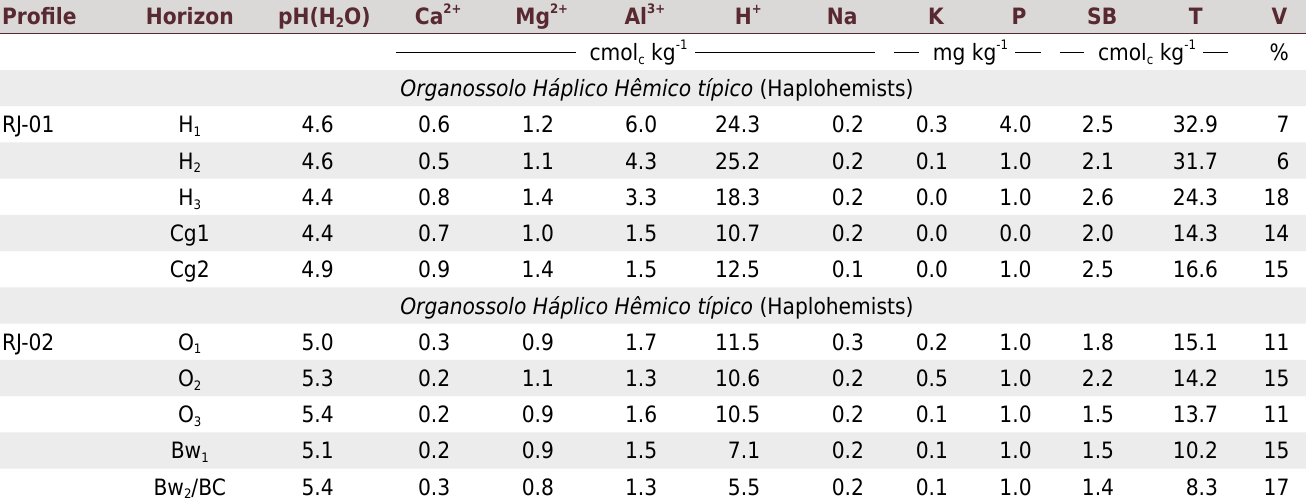
Table 2. Chemical properties of Organossolos in the upper montane environment of Itatiaia National Park, Rio de Janeiro, Brazil Profile